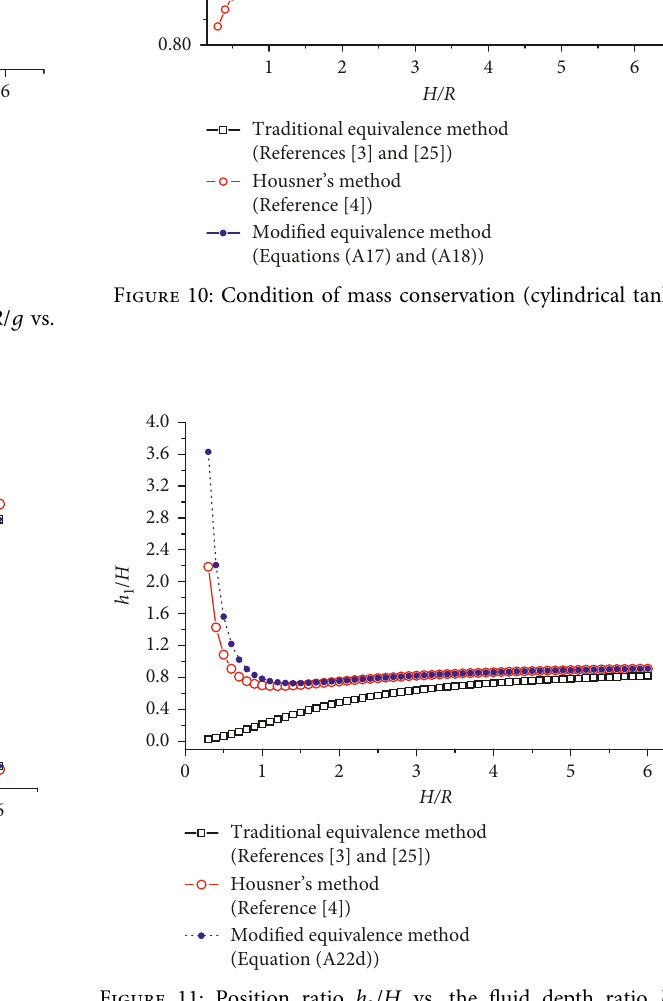
/ M and M / M vs. the fluid depth ratio 1 0